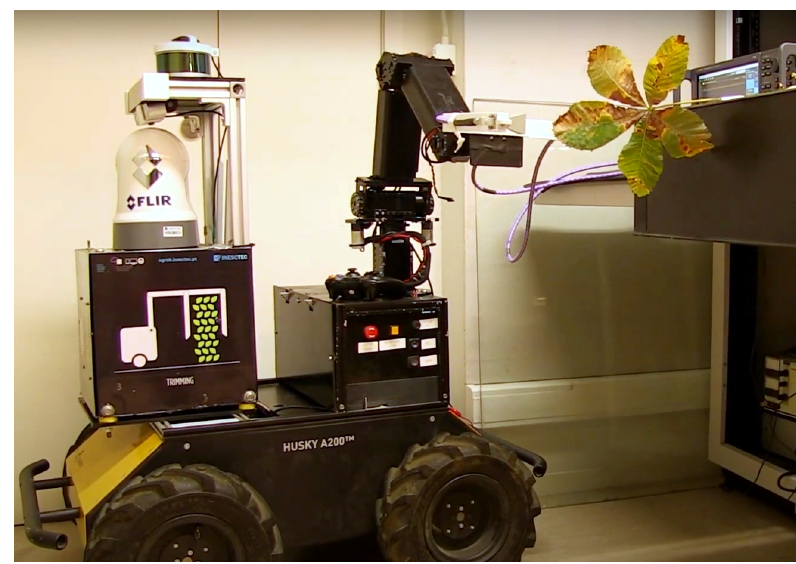
Figure 6. Previous Antennas setup with robotic manipulator.